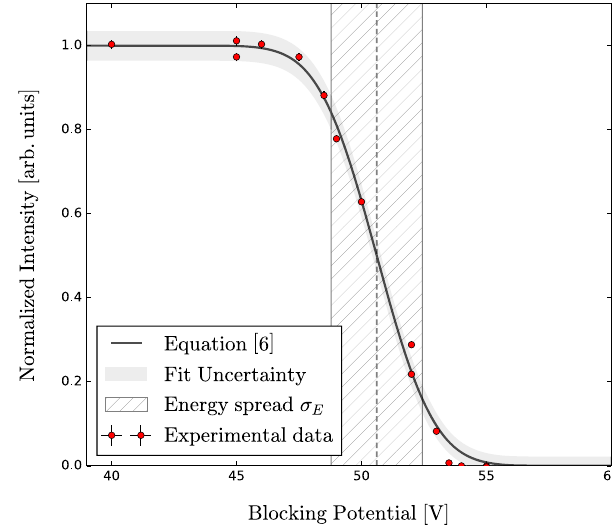
FIG. 13. Normalized ¯ p beam intensity at the BDS as a function of the blocking voltage applied inside the ALPHA-2 Penning trap. Equation (6) has been fitted to the experimental data to extract the beam energy and ¯ p energy spread. Many of the error bars are too small to be